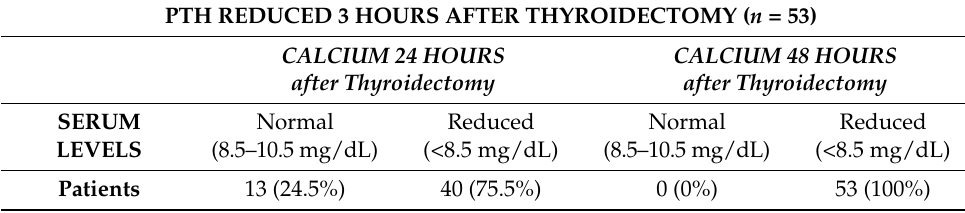
Table 3. Serum calcium levels in patients with low PTH after thyroidectomy.